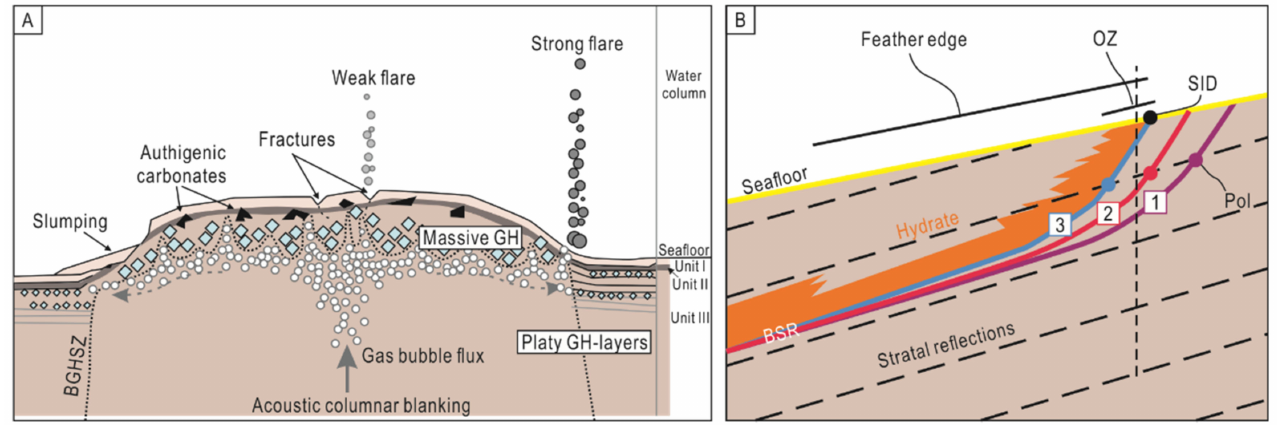
Figure 26. ( A ) Formation model of a hydrate-bearing mound at the Kerch seep area, Black Sea. Due to localized elevated temperatures, the BGHSZ (dark dashed line) shoals to various depths between tens to a few meters beneath the seafloor. The overlying sediments are pushed upward, causing the formation of seafloor hydrate-bearing mounds. Free gas migrates through the GHSZ via small-scale fractures or transports horizontally to the edges to form thin platy hydrates along the permeable horizon or to escape into seawater. ( B ) Schematic of the feather-edge region, displaying the positions of three hypothetical BSRs (1, 2, 3) shifting in response to water depths or seabed warming. Note: OZ: Outcrop zone; SID: Seabed intersection depth; Pol: Point of intersection. ( A is modified from [144]; B is modified from